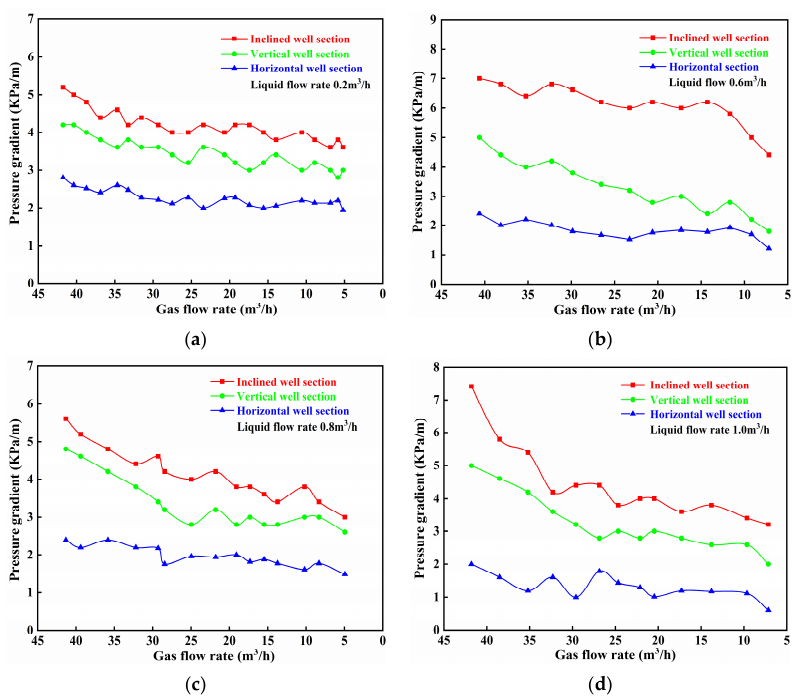
Figure 4. Pressure gradient of different sections with different liquid production rate: ( a ) top of deviated section; ( b ) heel of horizontal section; ( c ) 1/3 of horizontal section; ( d ) 2/3 of horizontal section. According to Figure 4, each section’s pressure loss is somewhat influenced by the various tubing depths. The pressure loss of the inclined part is almost three times more than that of other sections. By the time the tubing reaches its uppermost point, the hori ‐ zontal gas well construction resembles the conventional well structure. The flowing direc ‐ tion changes as the fluid moves through the inclined portion as the unique well structure of the inclined section. Gas–liquid two ‐ phase turbulence is created when the fluid is forced to collide with the tubing, severely reducing the gas–liquid two ‐ phase energy. The well tubing starter would also obstruct the fluid’s ability to flow freely through the upper portion of the inclined section. As a result of the drastic shift in flow direction and the increased two ‐ phase slippage, there is an additional energy loss that makes it difficult to remove the liquid from the horizontal gas well. The liquid phase loses more energy than the gas phase. The pressure loss of the inclined portion is depicted in Figure 5 in accordance with the laboratory simulation, which demonstrates the impact of various tubing depths on this segment’s pressure loss.